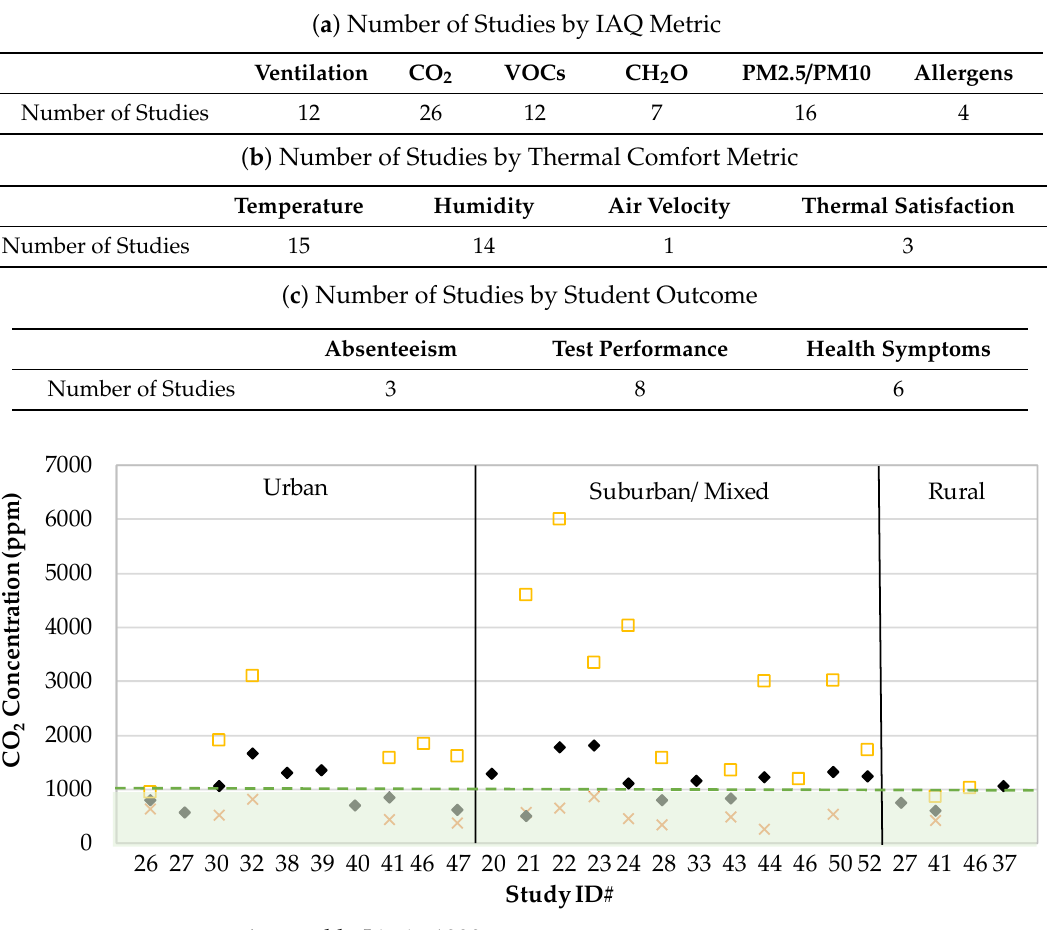
Table 1. Number of Studies Addressing (a) Specific Indoor Air Quality (IAQ) Metrics and (b) Specific Thermal Comfort Metric and (c) Student Outcomes (Total Number of Studies = 38) [7,15,18–53].